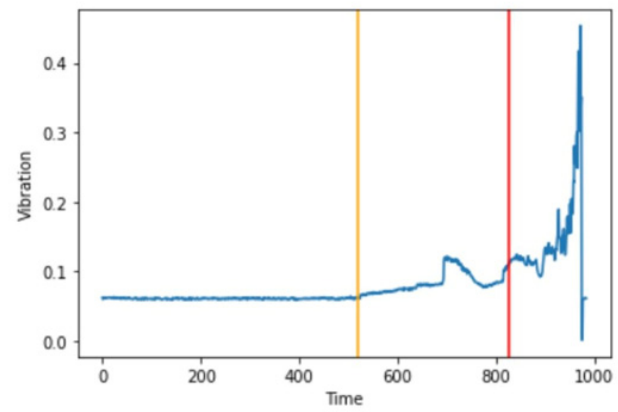
Figure 22. First anomaly and fault detection on Bearing 1.